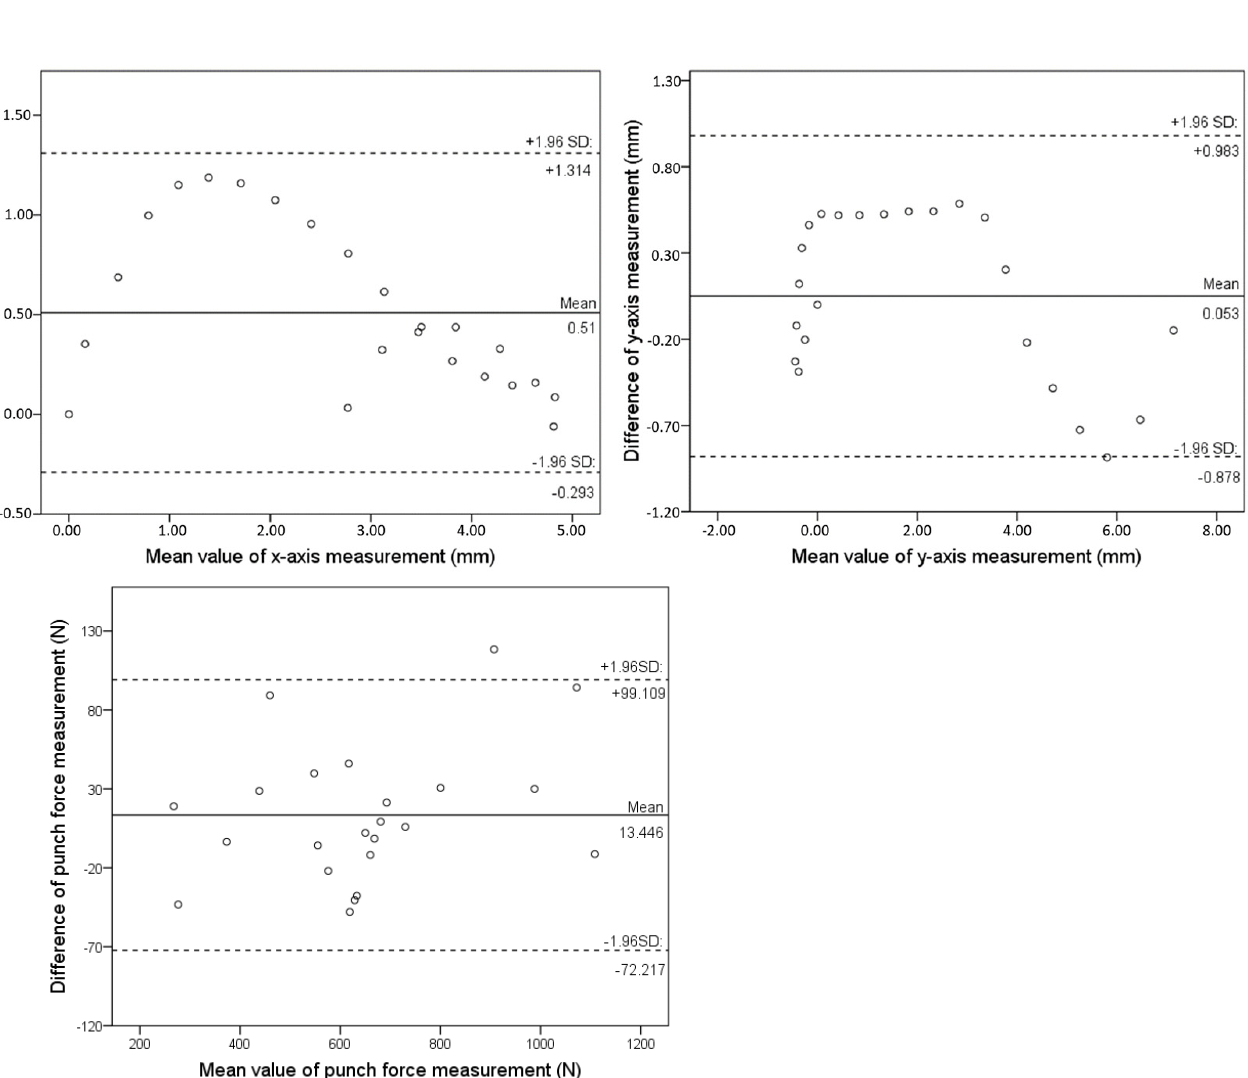
− 19.03 mm on the x-plane and 11.54 mm on the y-plane in a distal medial direction to the third proximal phalanges. At this point, the impact reaches the maximum impact force of 1753.4 N (SD = 485.92 N) on average for the subject tested. After reaching the maximum impact force the centre of pressure moves 12.56 mm in the x-direction and 3.4 mm in the y-direction, lateral to the second proximal phalanges. At this point, the fist separates from the target and is returned to the defensive